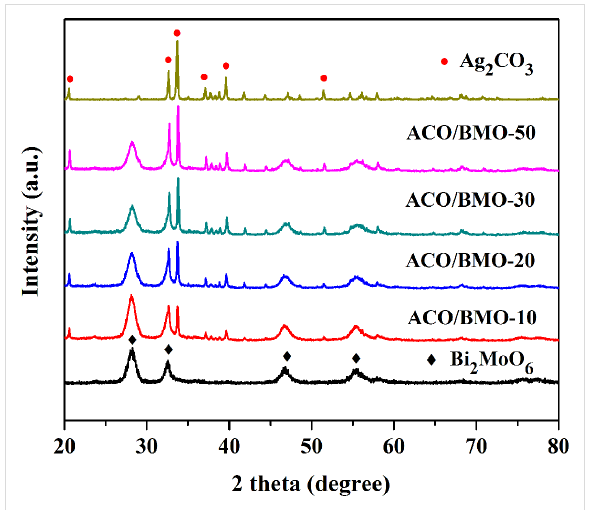
Figure 1: XRD patterns of Ag 2 CO 3 /Bi 2 MoO 6 heterojunctions, bare Bi 2 MoO 6 and Ag 2 CO 3